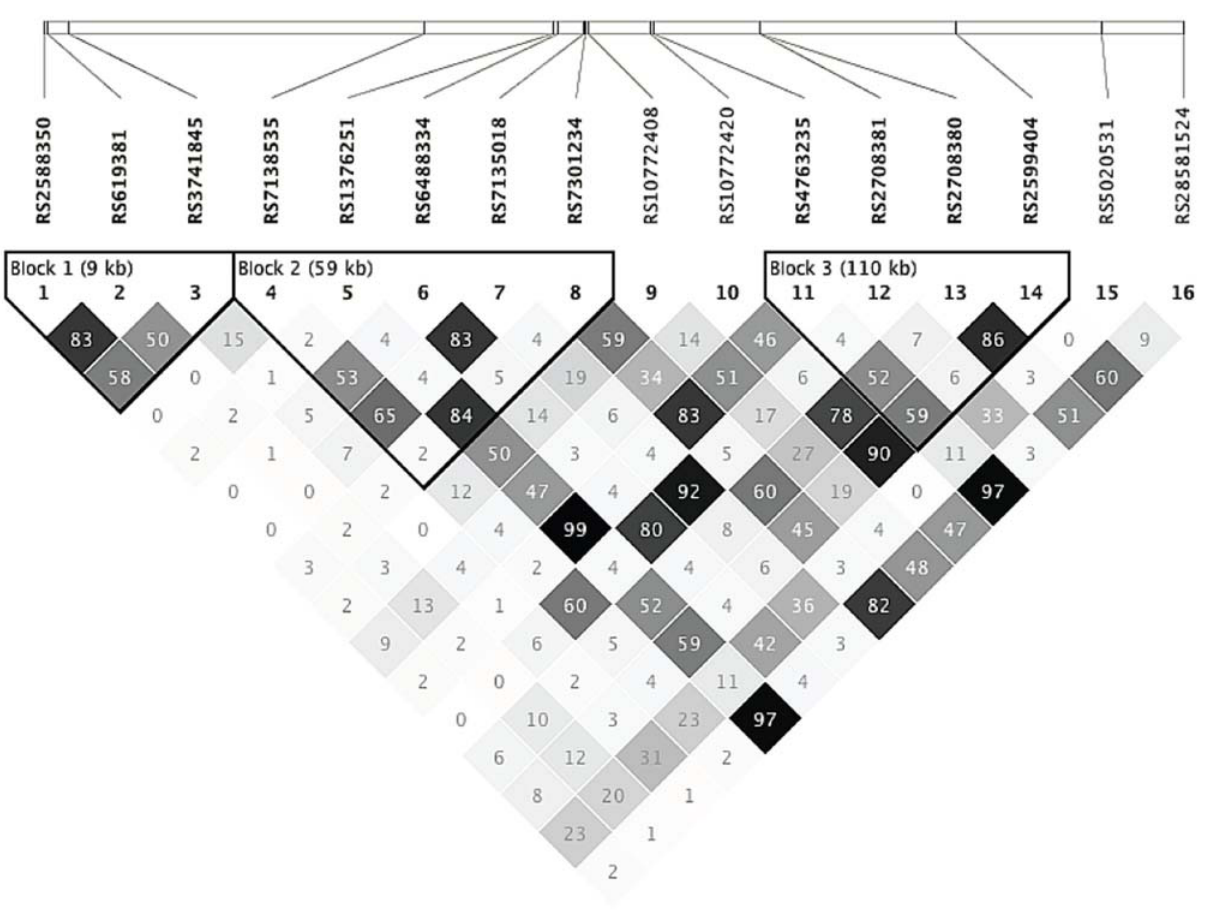
Figure 1. Haplotype structure of TAS2R SNPs on chromosome 12 in the AFDS. Pairwise LD (r 2 ) among 16 SNPs within the TAS2R cluster on chromosome 12. The relative position of rs3759245 is based on a non-reference assembly (Celera). r 2 values 6 100 are indicated within squares, and with darker shades indicating higher r 2 values.